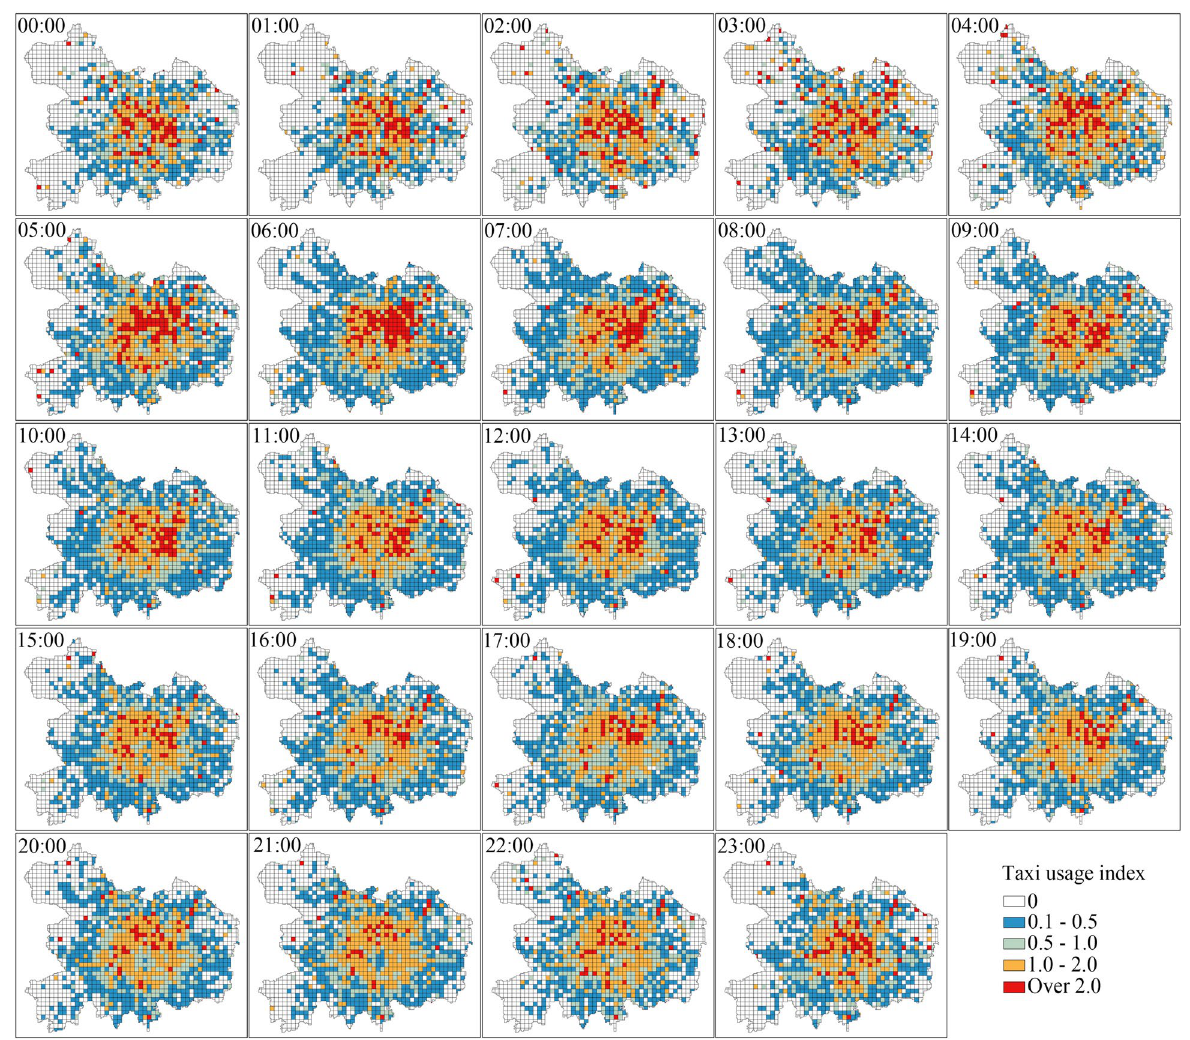
Fig. 3 Spatial patterns of the taxi usage index by